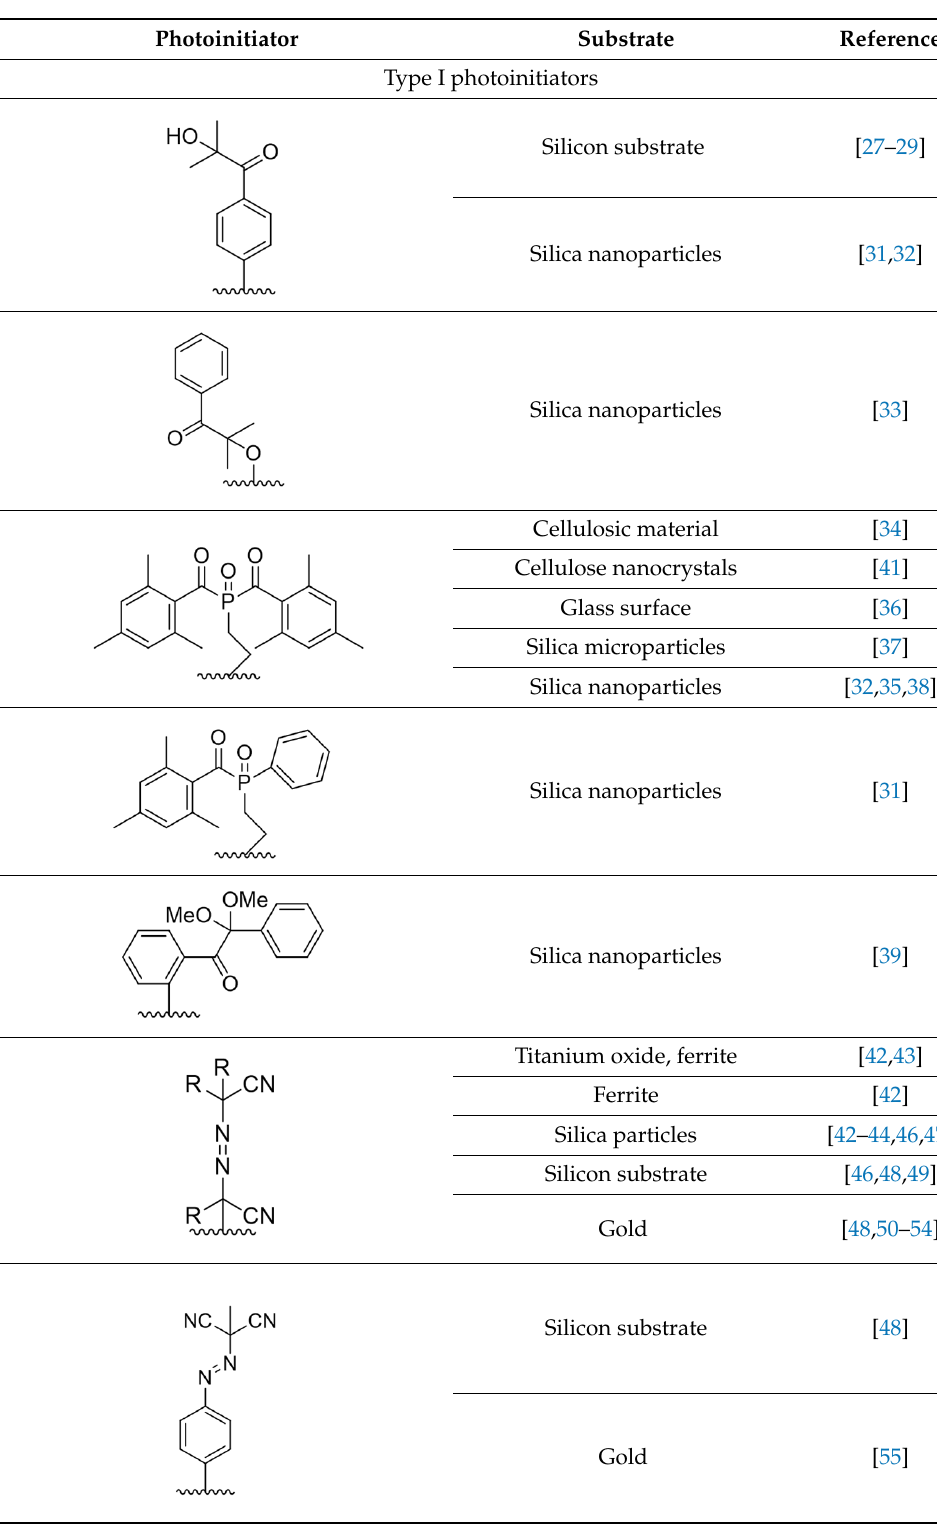
Table 1. Summary of surface coupled photoinitiators and co-initiators.